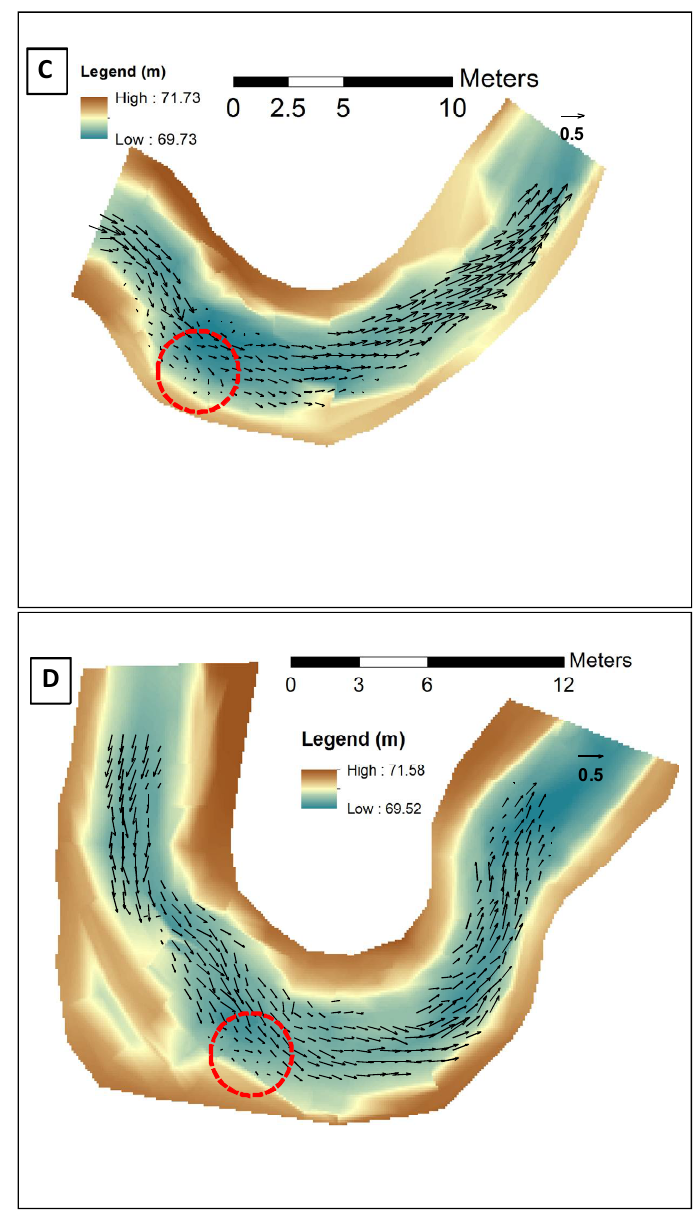
Figure 10. Measured depth-averaged ADCP velocities in the meander bends of the M4 sub-reach at: ( a ) first bend during August 2014 (low flow); ( b ) second bend during August 2014 (low flow); ( c ) fist bend during October 2014 (moderate flow); ( d ) second bend during October 2014 (moderate flow). Refer to Figure 1c for location of these bends. Surveyed bathymetric data (2014) are shown in the background. Note that the circles show the induced reverse eddies.